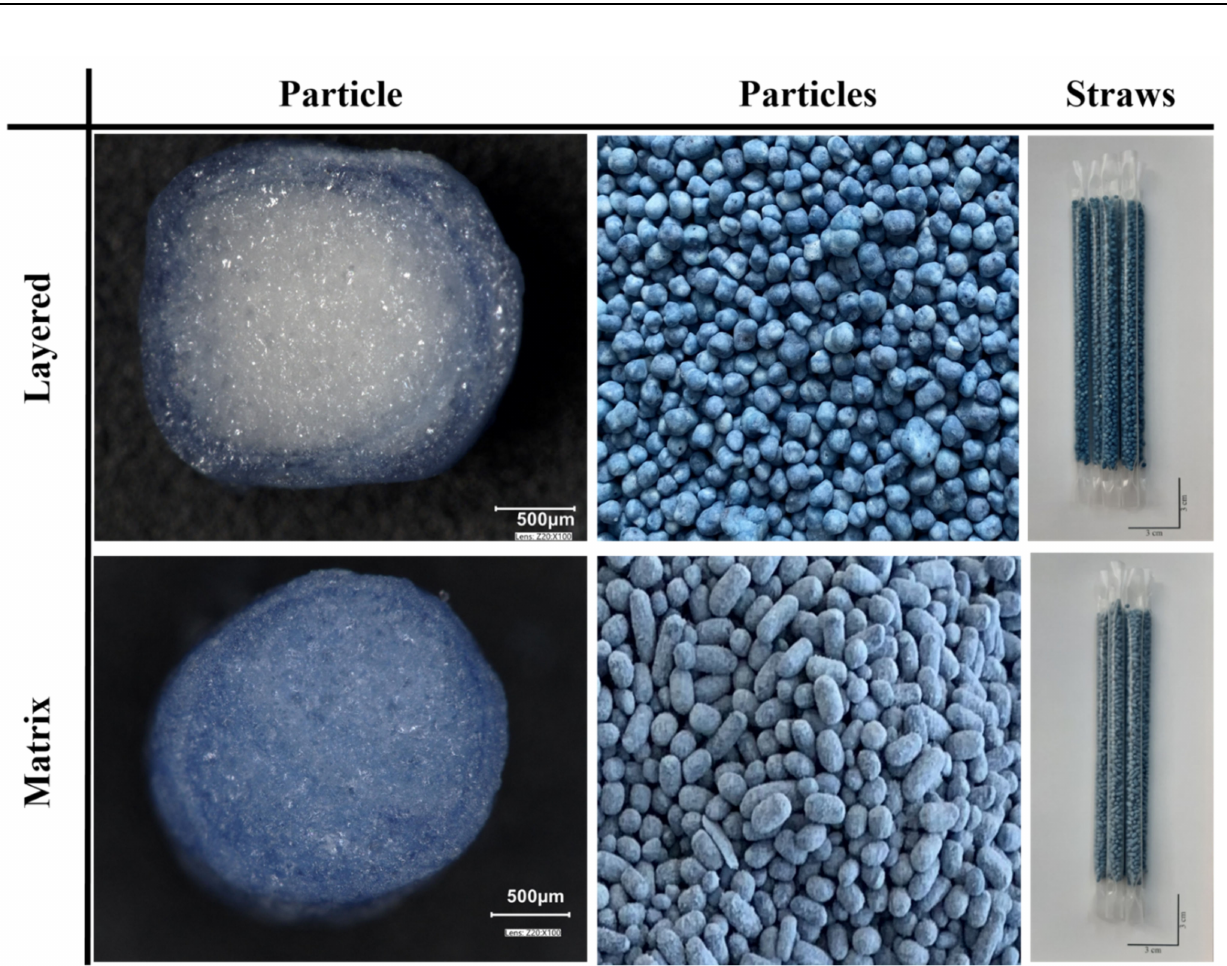
Figure 2. Microscopic images of the halved particles prepared by layering technique and extru- sion/spheronization method. Photograph of the particles in bulk and of the straws filled with the various particles